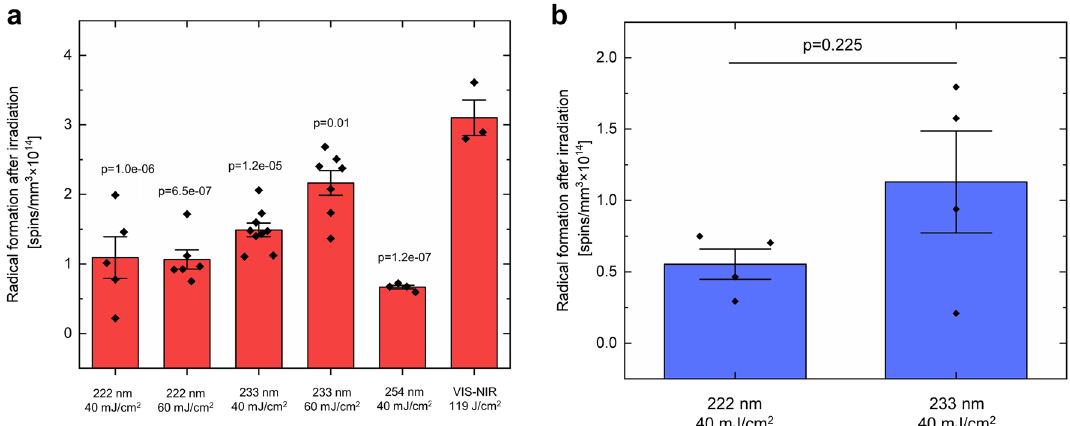
Figure 6. Radical formation of RHEs ( a ) and excised human skin ( b ) after UV irradiation. The data show the spin concentration (spins/mm 3 × 10 14 ) representative for radical formation in RHEs ( a ) and excised human skin ( b ) after irradiation with different wavelengths and irradiation doses. The corresponding p -values were obtained by comparing the different UVC wavelengths against VIS–NIR by one-way ANOVA with Dunnett post hoc tests for RHEs ( a ). All groups showed significantly lower radical formation in comparison to VIS–NIR. In excised human skin ( b ), the radical formation after irradiation with 233 nm (40 mJ/cm 2 ) was twofold higher compared to irradiation with 222 nm (40 mJ/cm 2 ). Radical formation was compared with the Student’s t -test for paired samples and showed no significant differences. Data were collected with n = 3 to n = 9 RHE models and n = 4 donors of excised human skin with 2 to 3 technical replicates, each. The data show mean ±